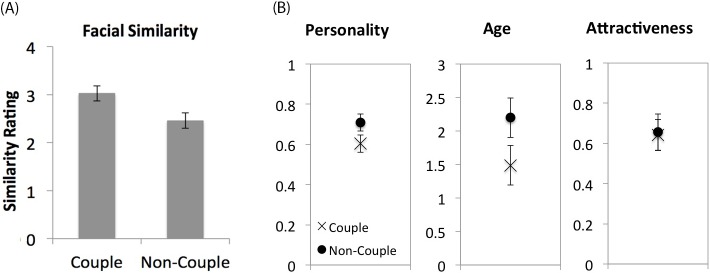
Results of Experiment 1.(A) Facial similarity in couples and non-couples rated by judges. The error bars represent the 95% confidence intervals for the difference between couple and non-couple faces. (B) Differences in perceived personality, perceived age and perceived attractiveness in face pairs of couples compared with that in non-couple pairs generated by bootstrapping. For perceived age, each unit represents 1/3 of a decade. The error bars represent the 95% confidence intervals of each condition.